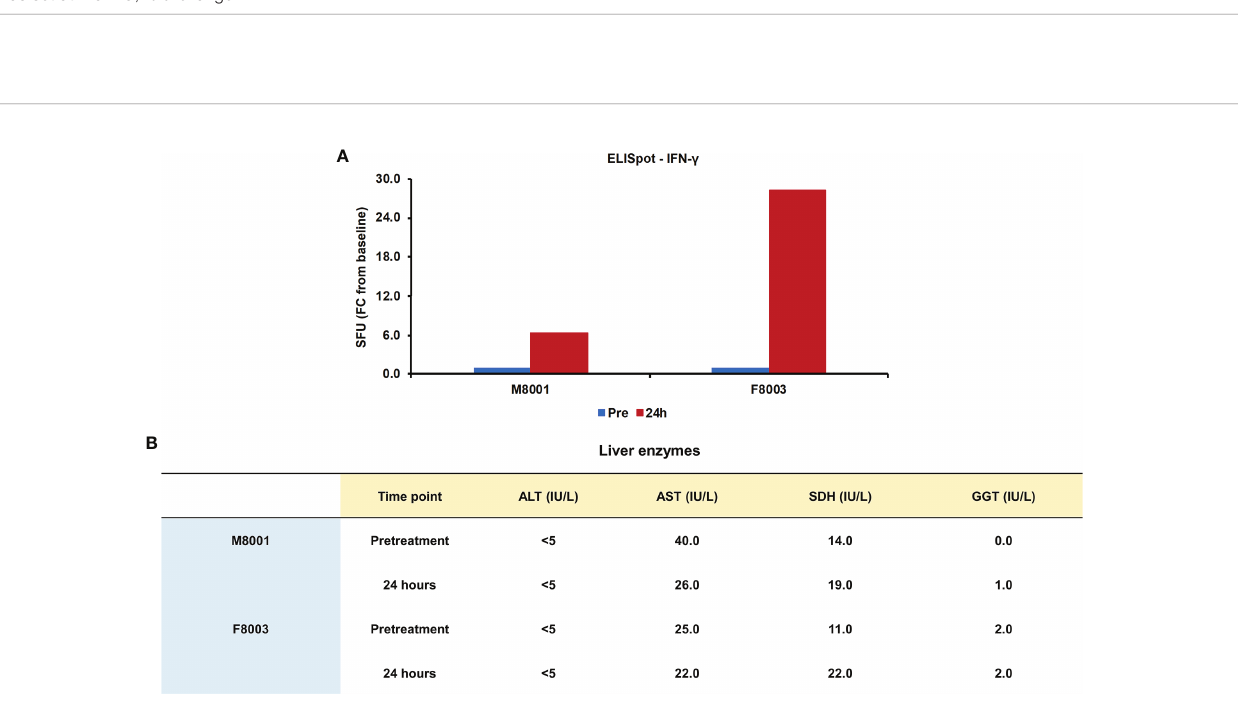
FIGURE 8 | Single dose administration of poly(dA:dT) to woodchucks results in an increased number of IFN- g secreting blood cells and nearly unchanged liver enzymes. (A) PBMCs from animals M8001 and F8003 were isolated 24 hours after intravenous injection of a single low (M8001) or high (F8003) dose of poly(dA:dT) in in vivo -jetPEI-Gal transfection reagent and subjected to an ELISpot assay. The fold-changes in spot-forming units (SFU) are shown, when compared to the spot number at pre-treatment in PBMCs from both animals, which was set at 1.0. (B) The levels of ALT, AST, SDH, and GGT in serum of both animals measured prior to treatment and at 24 hours post-treatment are shown. The normal range of liver enzyme levels in WHV-uninfected woodchucks is 1-6 IU/mL for ALT, 9-55 IU/mL for AST, and 0.8-2.6 IU/mL for GGT (46). For SDH, the normal range in WHV-uninfected woodchucks is 7-31 IU/mL (47). FC, fold-change; IU, international